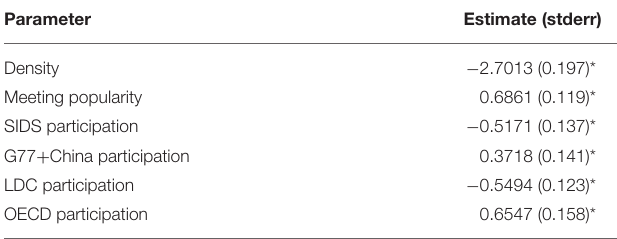
TABLE 3 | Exponential random graph modeling (ERGM)